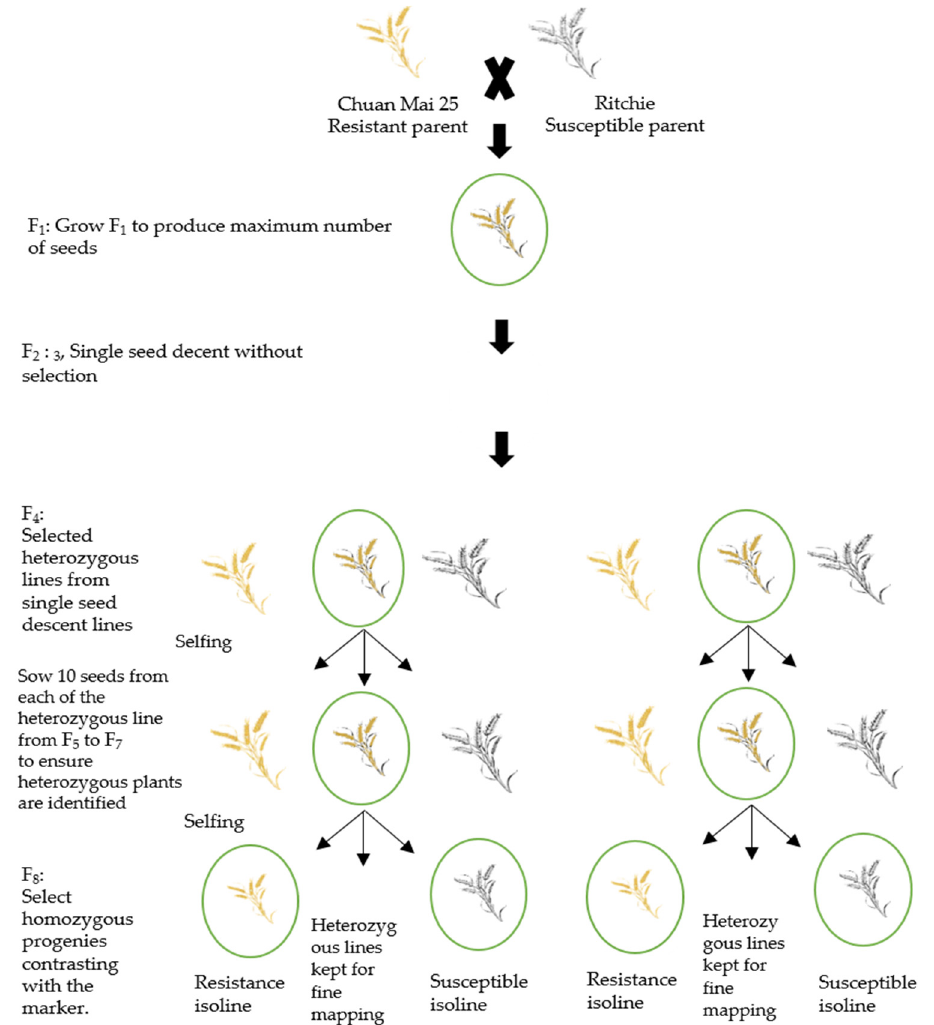
Figure 5. Process for developing near-isogenic lines (NILs). The heterogeneous inbred family method (Tuinstra et al. 1997) was used to develop the NIL pairs. Molecular markers were used to select heterozygous lines from F 4 to F 7 . Putative near-isogeneic line pairs were selected at F 8 from each of the F 7 heterozygous lines.